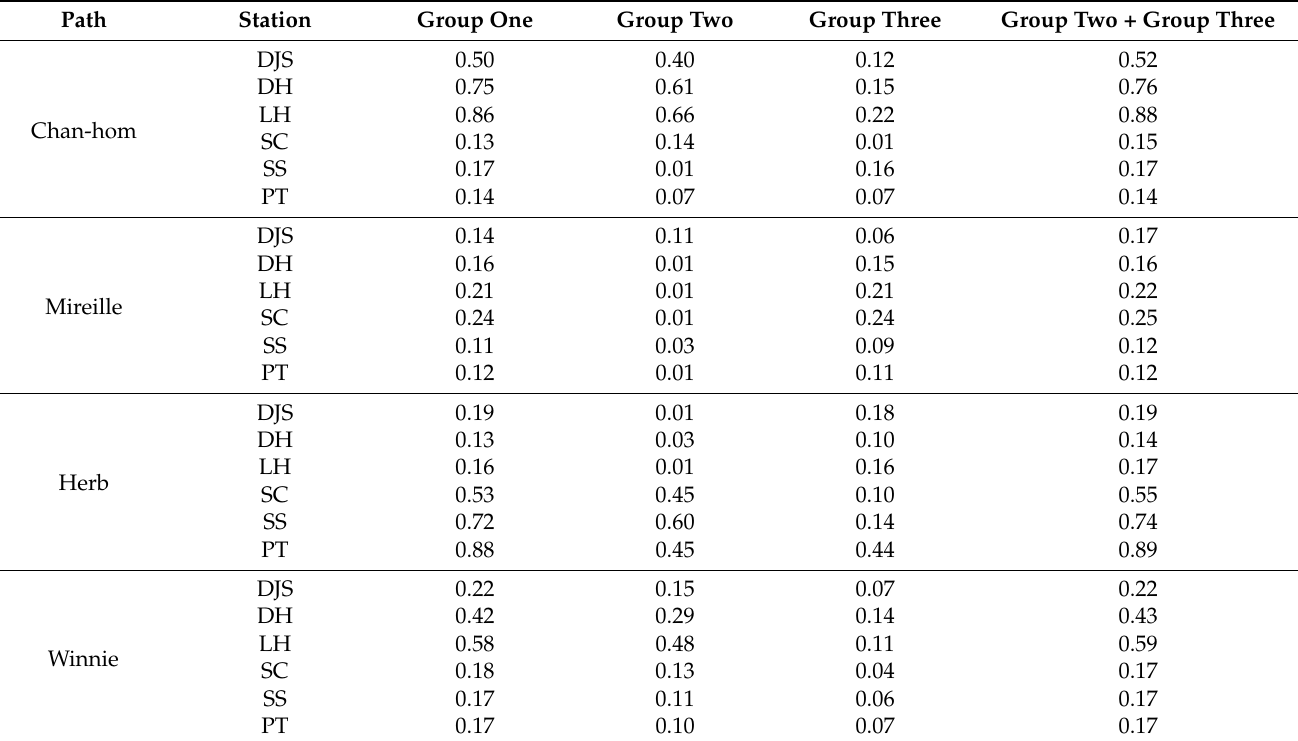
Table 5. The model results of peak surges in group one, group two, and group three at each station during with four paths. Path